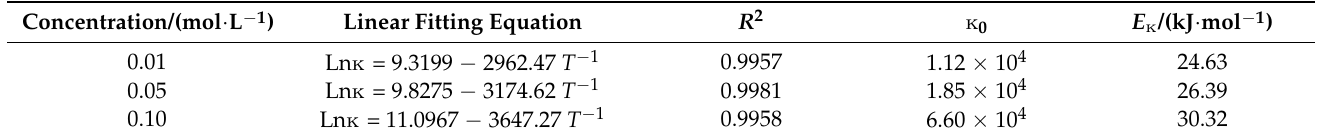
Table 2. Arrhenius Equations of Conductivity Along with the Corresponding Parameters.